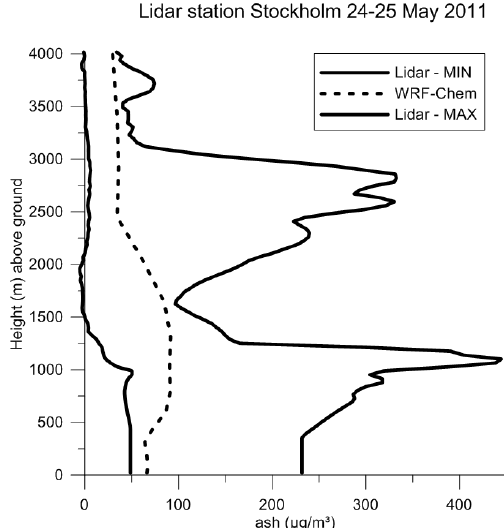
Figure 10. Min–max observed ash concentrations values at the li- dar Stockholm (25 May 02:00 until 08:00) compared to the WRF- Chem maximum ash concentrations (24 May 19:00 until 25 May 03:00UTC) for each vertical level.